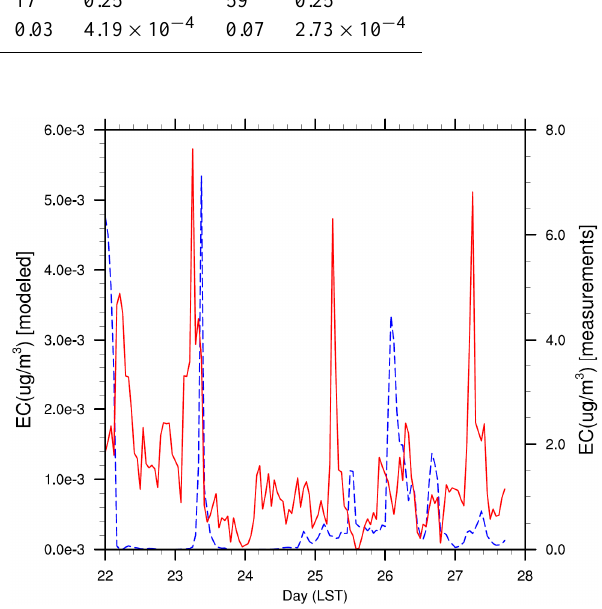
Fig. 4. Time series of EC obtained with the soot mass rate obtained with the combustion model (dashed blue) and measurements (red) at